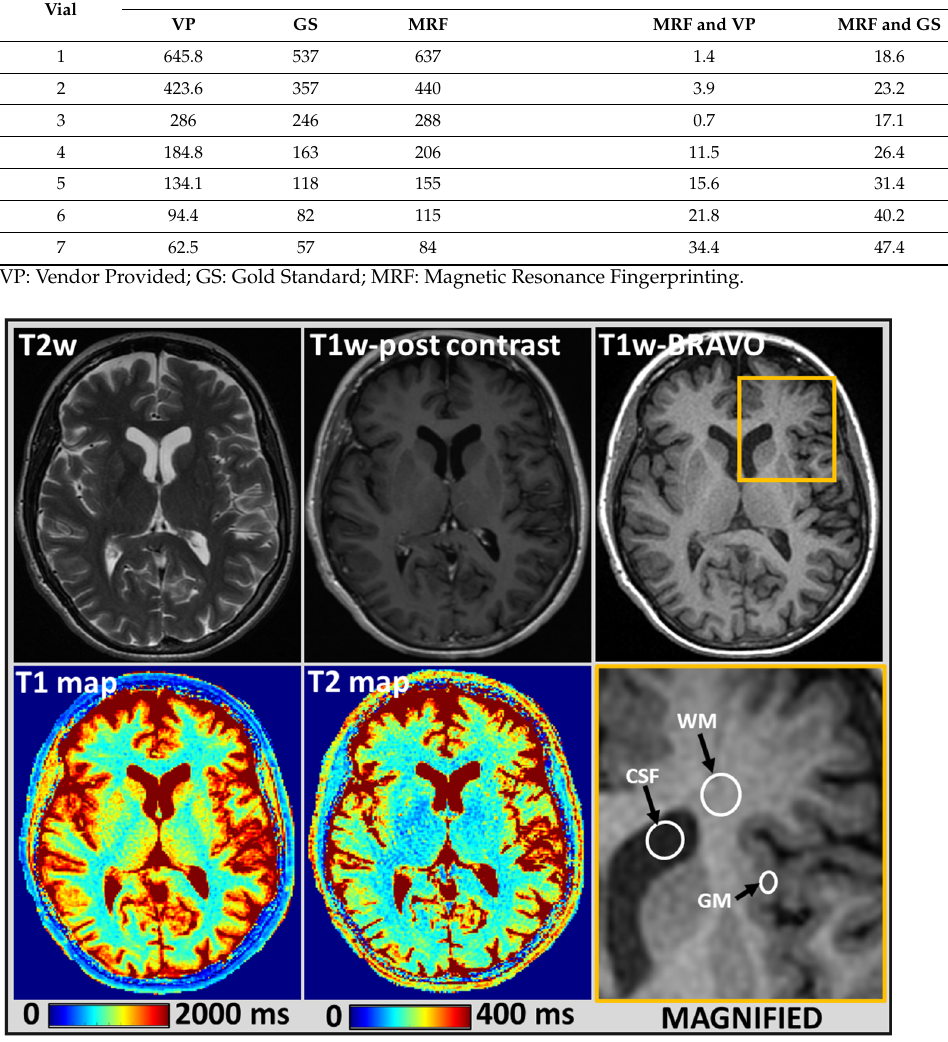
Figure 1. Representative MR images showing normal-appearing brain tissue from a 52-year-old female patient treated with focal RT and had a history of primary melanoma: Conventional T2-weighted (w), post-contrast T1w and BRAin VOlume (BRAVO) images depicting the anatomical structures ( top row ). T1 and T2 maps estimated using MRF for a single slice exhibiting gray matter (GM), white matter (WM), and cerebrospinal fluid (CSF) ( bottom row ). The yellow outlined region on a BRAVO image was magnified, and the placement of region of interest (ROI) is in white for normal-appearing GM, WM, and CSF. The MRF estimated mean T1 values for these normal-appearing GM, WM, and CSF regions were 1204 ms, 842 ms, and 4190 ms, respectively, and the mean T2 values were 108 ms, 78 ms, and 442